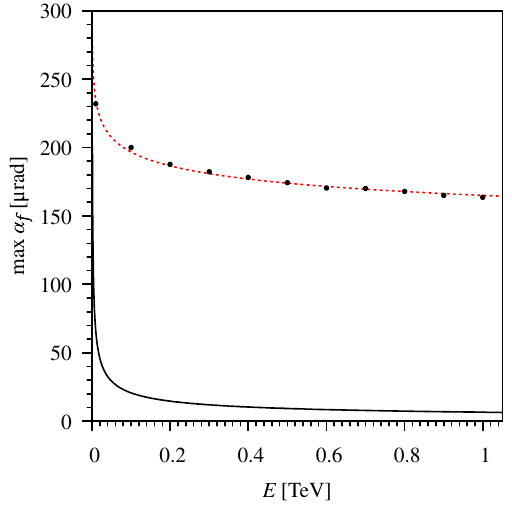
Fig. 4 The dependence of the maximum angle by which the fraction of particles f = 0 . 1 can be deflected on the particle energy. The black solid curve shows the dependence of the critical angle of the planar channeling on the particle